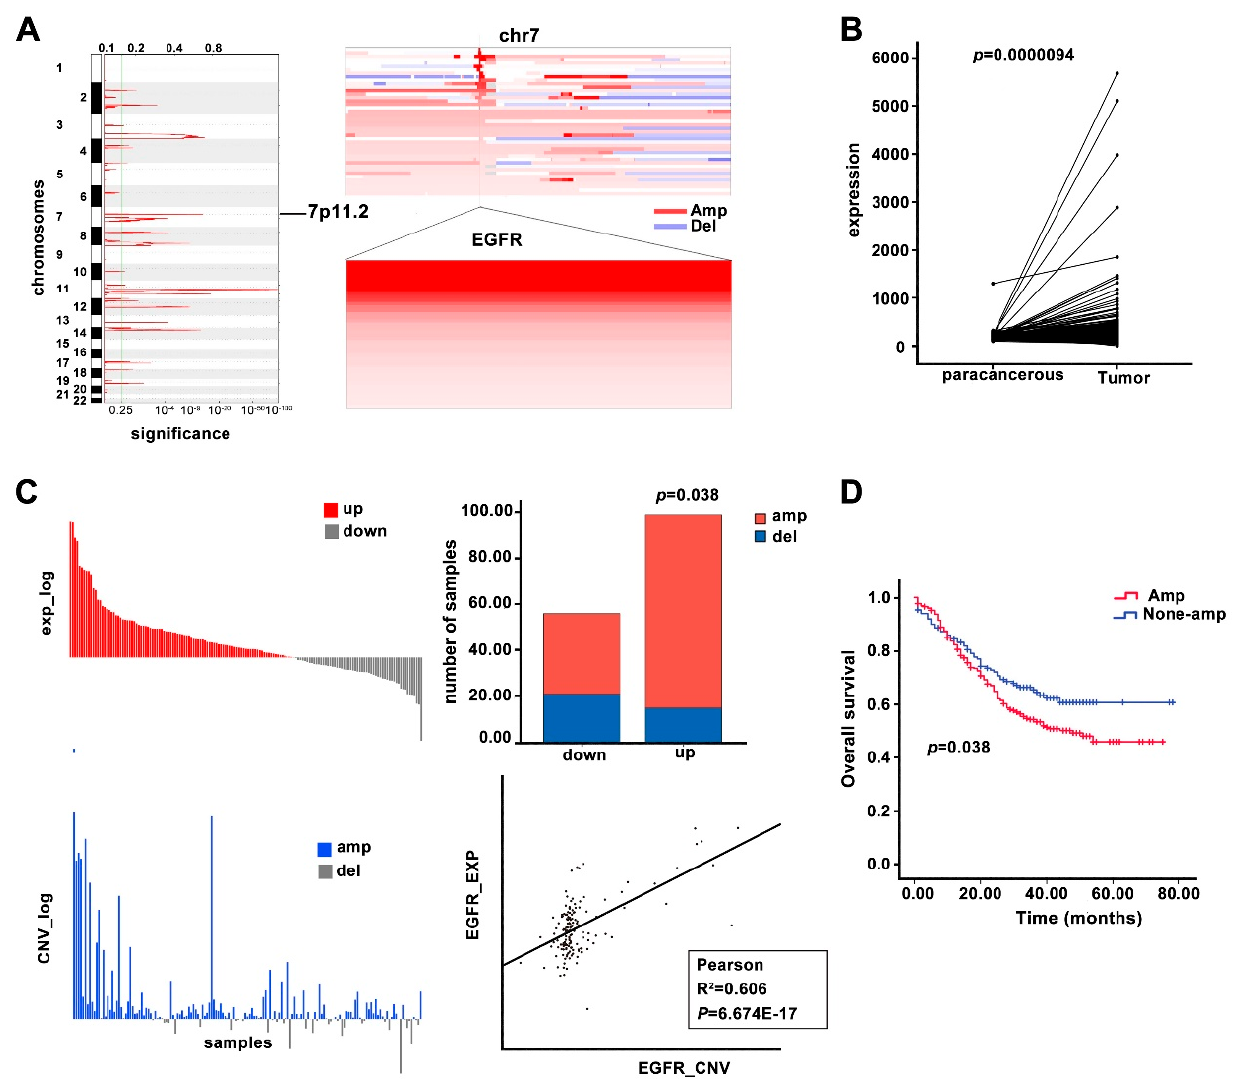
Figure 1. Copy number alteration and mRNA expression of the EGFR gene in ESCC. ( A ) Significant amplification of EGFR in ESCC patients ( n = 508) revealed by WGS. Left panel: Copy number amplification region in the human chromosome of ESCC patients. Right panel: Copy number alteration of EGFR gene c in ESCC. ( B ) Differential expression of EGFR mRNA revealed by RNA-seq analysis ( n = 155). ( C ) Correlation between EGFR amplification and expression. Top left panel: log value of expression of EGFR in each ESCC sample. Bottom left panel: log value of CNV of EGFR in each ESCC sample. Top right panel: ESCC sample number statistics of EGFR expression